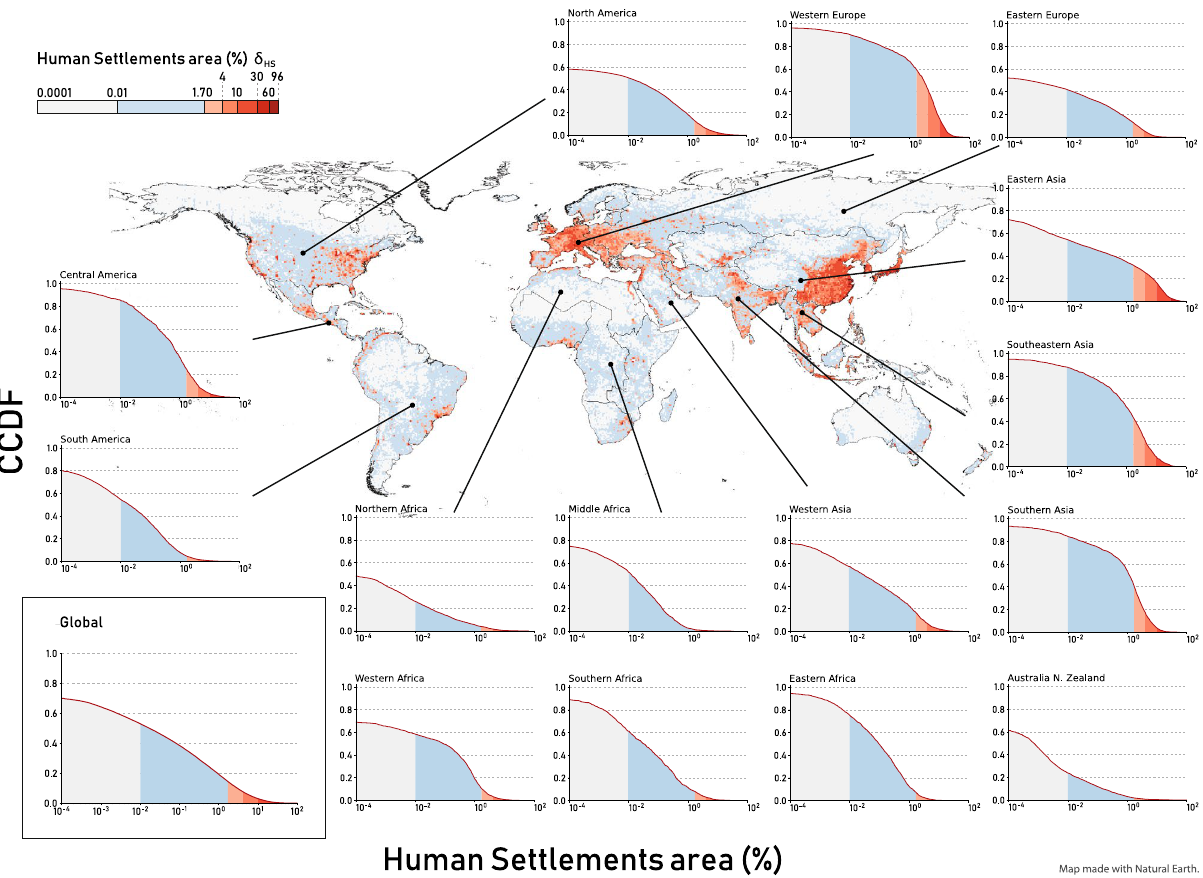
Figure 1. A global overview of HSs density in 2015. For each tile, we compute the percentage of occupied HS area in each tile δ HS and find that, on average, HSs cover 1.70% of the tile area. Inset: the long-tail distribution of the cumulative frequency of the percentage of occupied HS area within each tile, δ HS . A small number of tiles contains the majority of the settlements. Map: we colour in cyan the tiles with δ HS less than the global average density ( 1.70% ), while we colour with a red gradient the areas with a density between 1.70% and 100% . High- density tiles are not evenly distributed in the world. Small plots: we show how the global long-tail emerge in all the UN-defined